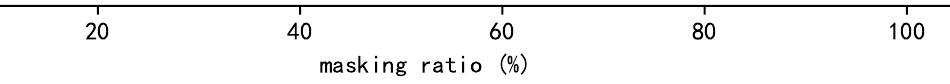
Figure 13. The influence of masking